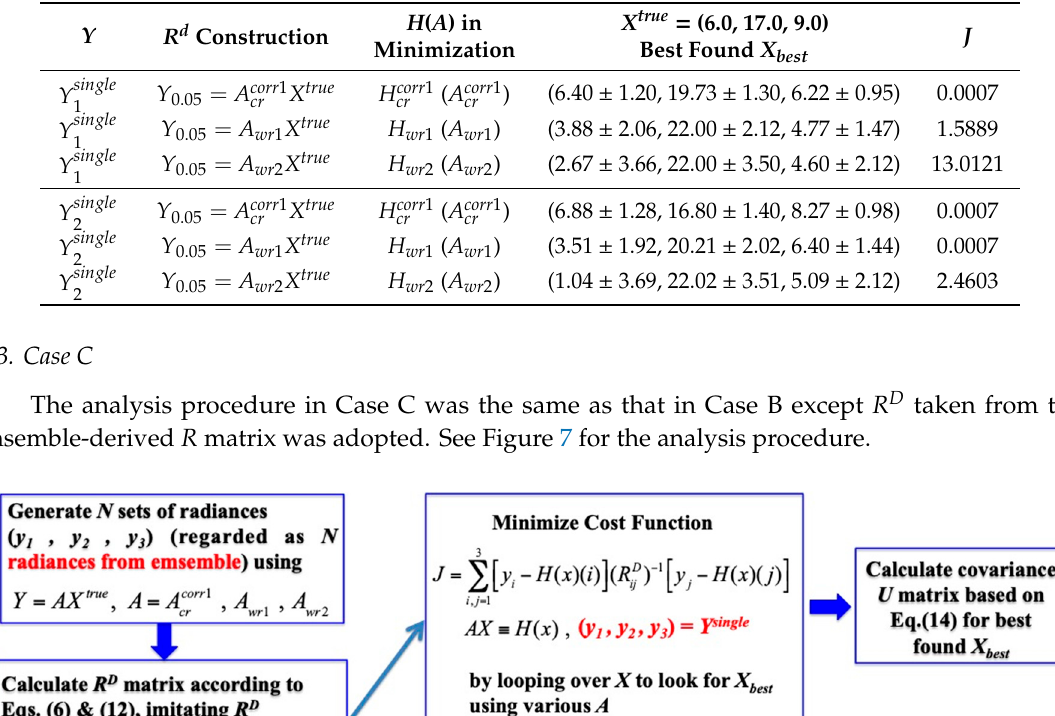
Figure 6 . Analysis procedures for Cases B, where FM uncertainty and RE stand for forward model uncertainty and representativeness error, respectively. Table 2. Results for Case B, where 𝑌 (cid:2869)(cid:3046)(cid:3036)(cid:3041)(cid:3034)(cid:3039)(cid:3032) (or 𝑌 (cid:2870)(cid:3046)(cid:3036)(cid:3041)(cid:3034)(cid:3039)(cid:3032) ) means data from single measured radiance, the second column means 𝑅 (cid:3031) matrix is based on what for construction, and the third column represents what 𝐻 ( 𝐴 ) is used in minimization. Table 2. Results for Case B, where Y single (or Y single ) means data from single measured radiance, 2 1